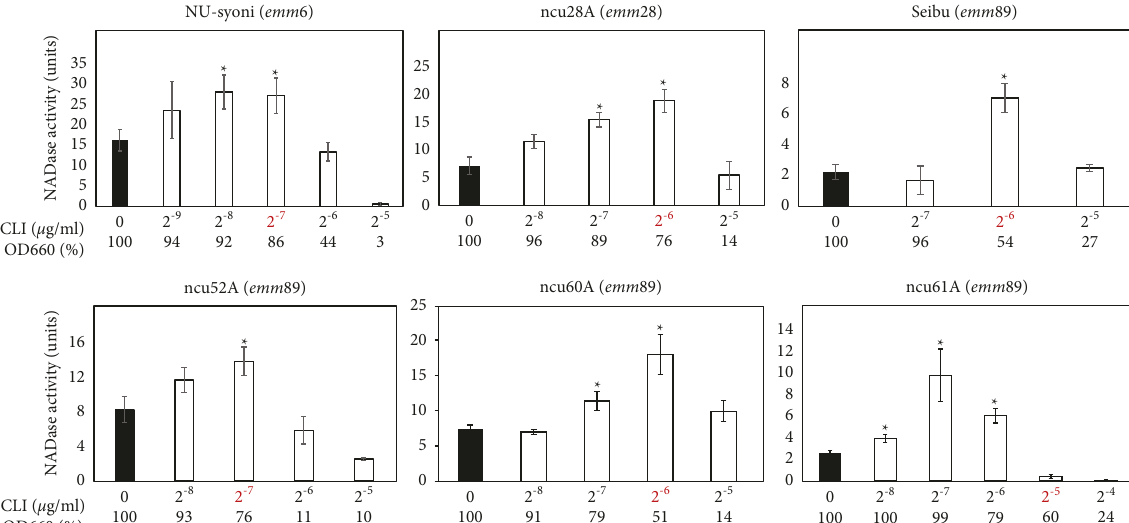
Figure 4: Extracellular NADase activity in emm 6, emm 28, or emm 89 strains cultured with CLI. NADase activity was determined based on the criteria described in Figure 1. The OD 660 of overnight culture with CLI (2 − 9 to 2 − 4 μ g/ml) is shown by a percentage (%) of that without CLI (0 μ g/ml). The maximum CLI concentration that did not suppress the bacterial growth to less than 50% of that without CLI is shown in red, which was 2 − 7 μ g/ml in strain NU-syoni, 2 − 6 μ g/ml in strains ncu28A and Seibu, 2 − 7 μ g/ml in strain ncu52 A, 2 − 6 μ g/ml in strain ncu60A, 2 − 5 μ g/ml in strain ncu61A, respectively. At least three independent experiments were performed. Error bars indicate the standard errors of the means. Significant increases in extracellular NADase activity by CLI treatment when compared with that without CLI treatment, which is shown by the black bar, are marked with asterisks ( ∗ p < 0 . 05 using Student’s t -test).